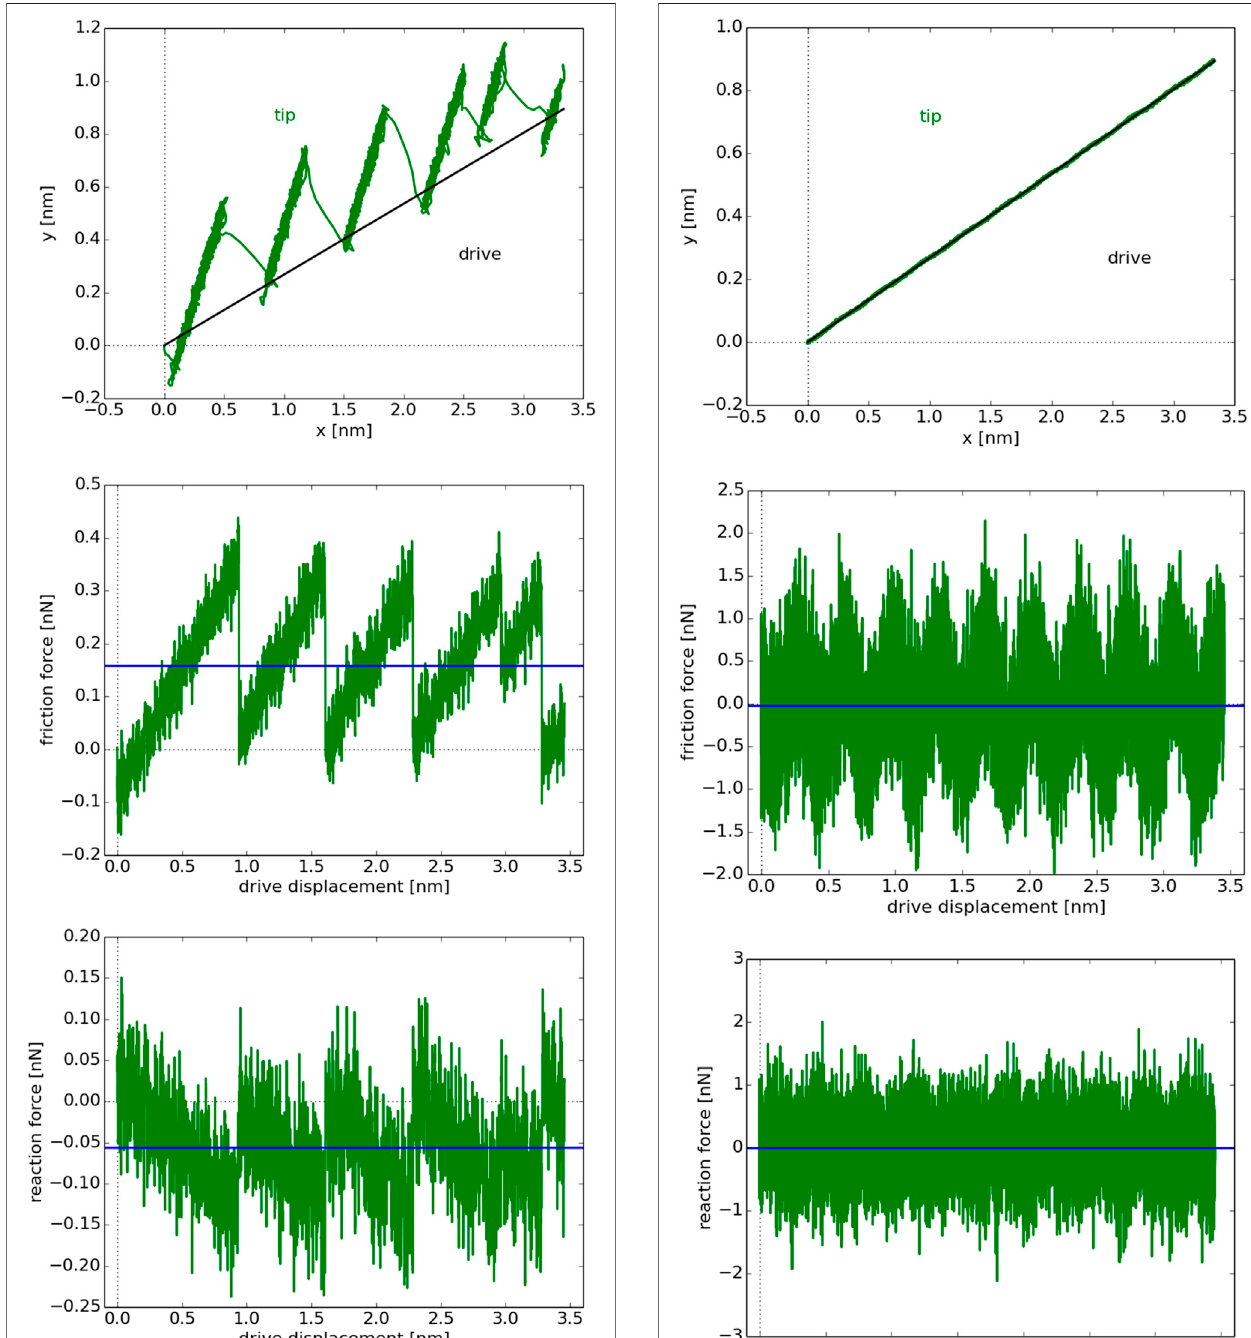
Frontiers in Mechanical Engineering |